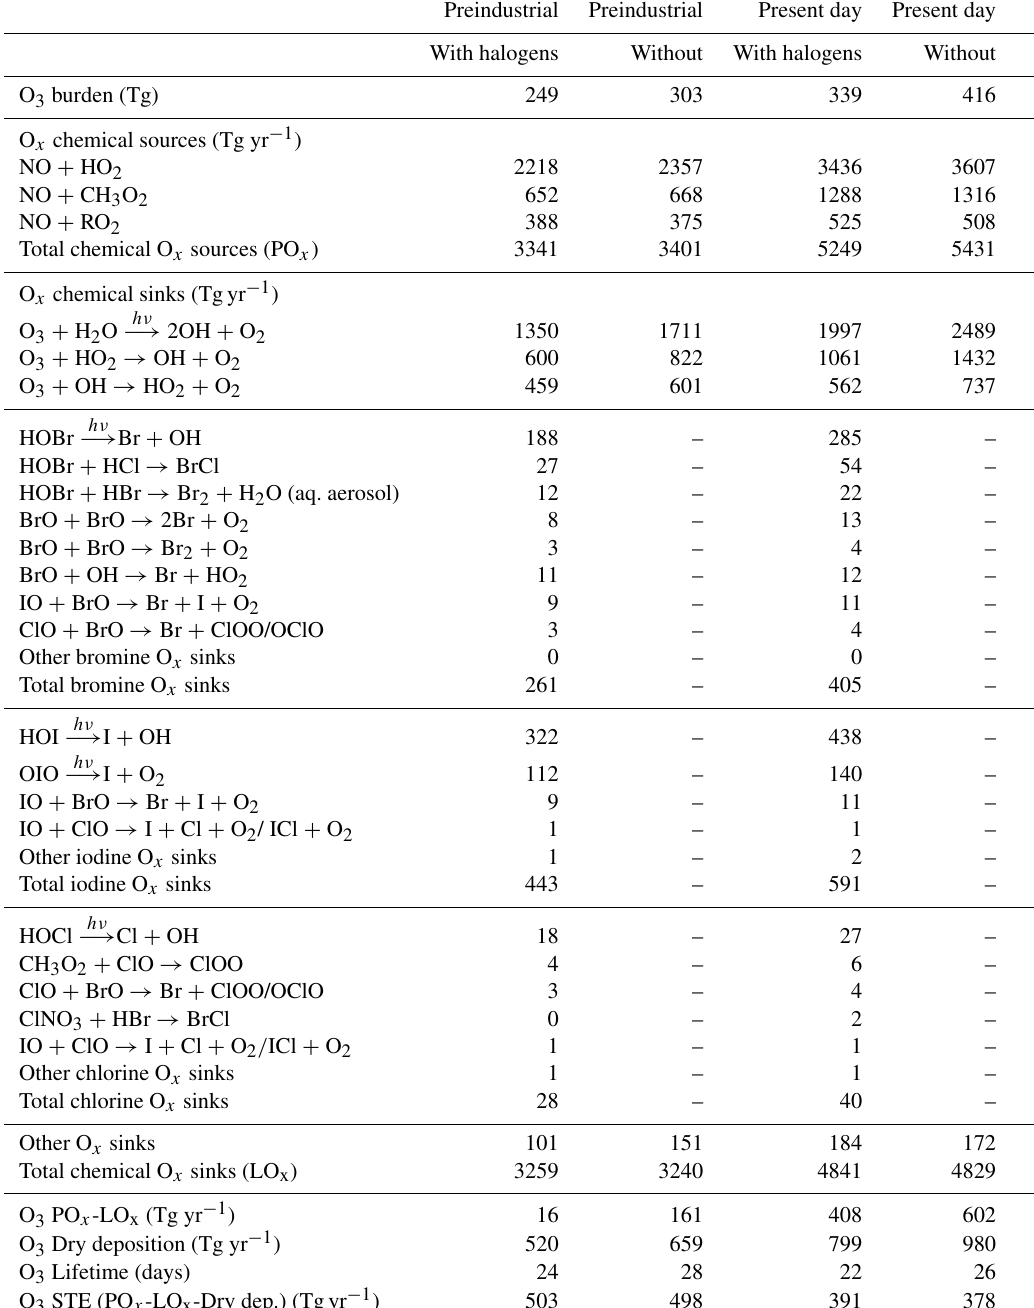
Table 3. Global tropospheric O x (defined in Table 2) budgets for preindustrial and present day, with and without halogens. For the X (cid:48) O + X (cid:48)(cid:48) O halogen crossover reactions where X (cid:48) (cid:54)= X (cid:48)(cid:48) we split the O x loss equally between the two routes. Values are rounded to the nearest integer